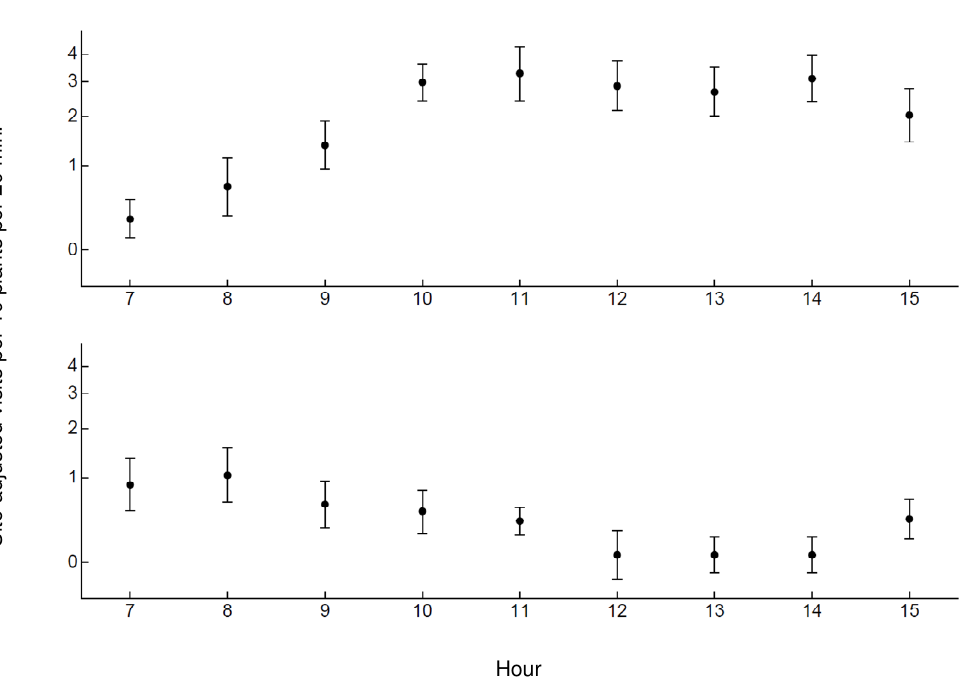
F IG . 3. Diurnal schedules of the visit rates of the two most common pollinator species of C. xantiana ssp . xantiana. Upper panel: Hesperapis regularis . Lower panel: Lasioglossum pullilabre . Symbols are least-squared means adjusted for among-site variation. Error bars represent ± 1 standard error.